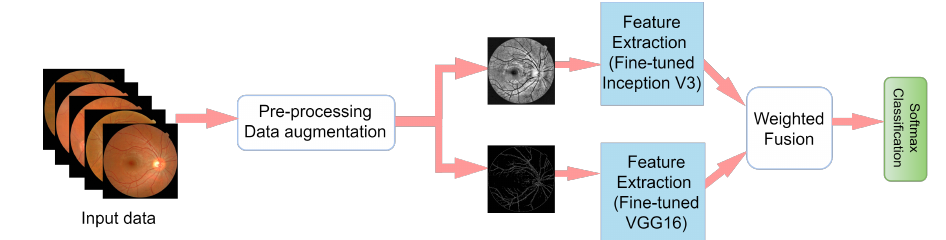
Figure 2. Pipeline of our proposed diabetic retinopathy identification based on a weighted fusion deep learning network.